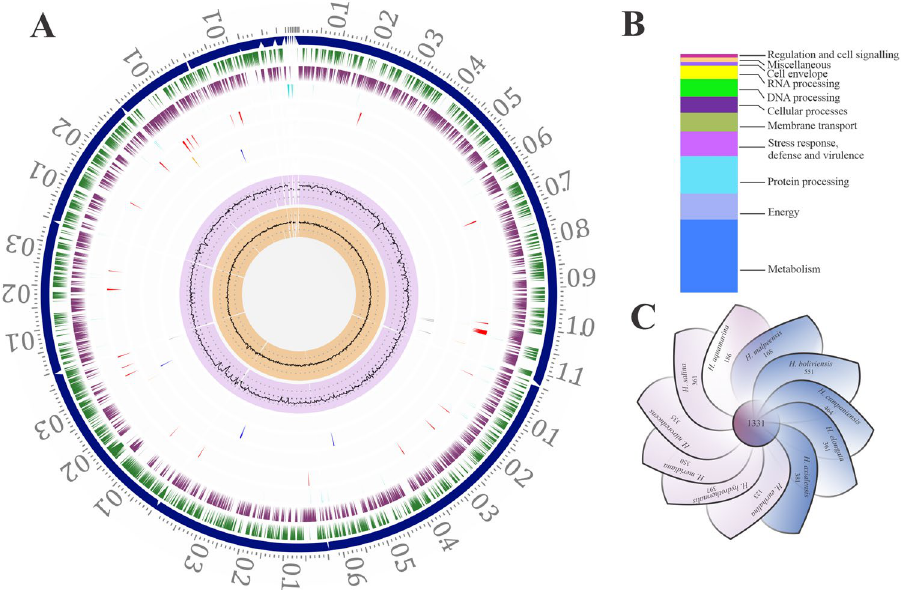
Figure 1. Genomic features and a comparative genomic analysis of H. malpeensis YU-PRIM-29 T . ( A ) Circular plot representing the genome annotations of H. malpeensis YU-PRIM-29 T . Circles are numbered from 1 (outermost) to 8 (innermost). Circle 1 represents the contigs; Circles 2 and 3 show the locations of predicted coding sequences (CDSs) on the forward and reverse strands, respectively; Circle 4, RNA genes; Circle 5, CDS with homology to known antimicrobial resistance genes; Circle 6, CDS with homology to known virulence factors; Circle 7, % G + C; Circle 8, GC skew [(G − C)/(G + C)]. ( B ) Bar-chart representing PATRIC subsystems in the H. malpeensis YU-PRIM-29 T genome. ( C ) Genomic diversity of 11 Halomonas strains. Each strain is represented by a petal. The central number represents the orthologous CDSs present in all strains. Overlapping regions show the number of CDSs conserved only within the specified genomes, while the number of CDSs unique to each strain is represented in non-overlapping portions. The total number of CDSs within each genome is enumerated beneath the strain name.